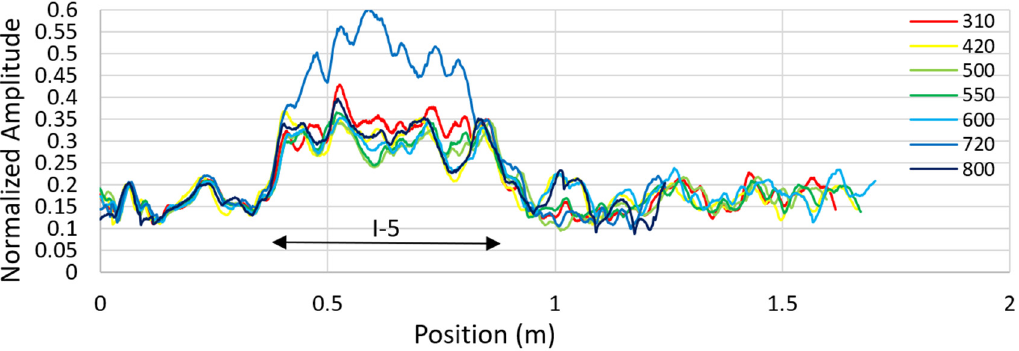
Figure 30. 2.6 GHz Normalized RW amplitudes on defect I-5, in the longitudinal direction vs. K loadings.